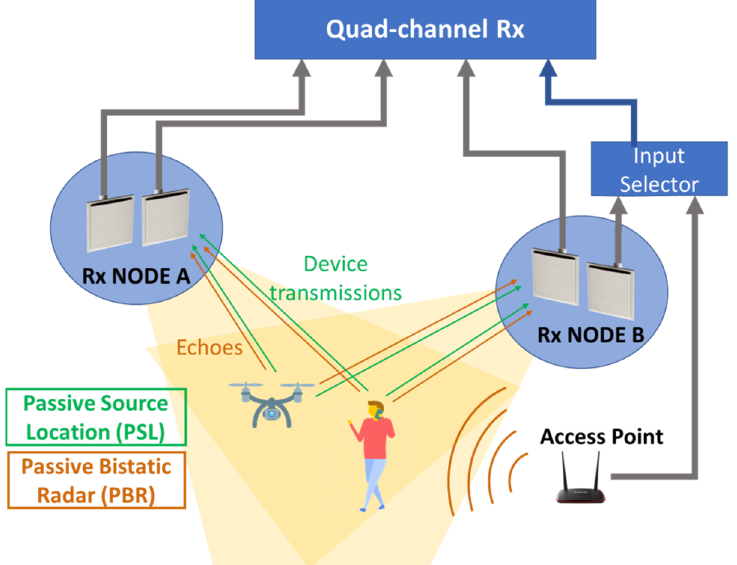
Figure 1. Sketch of a system setup implementing the PBR and PSL approaches.